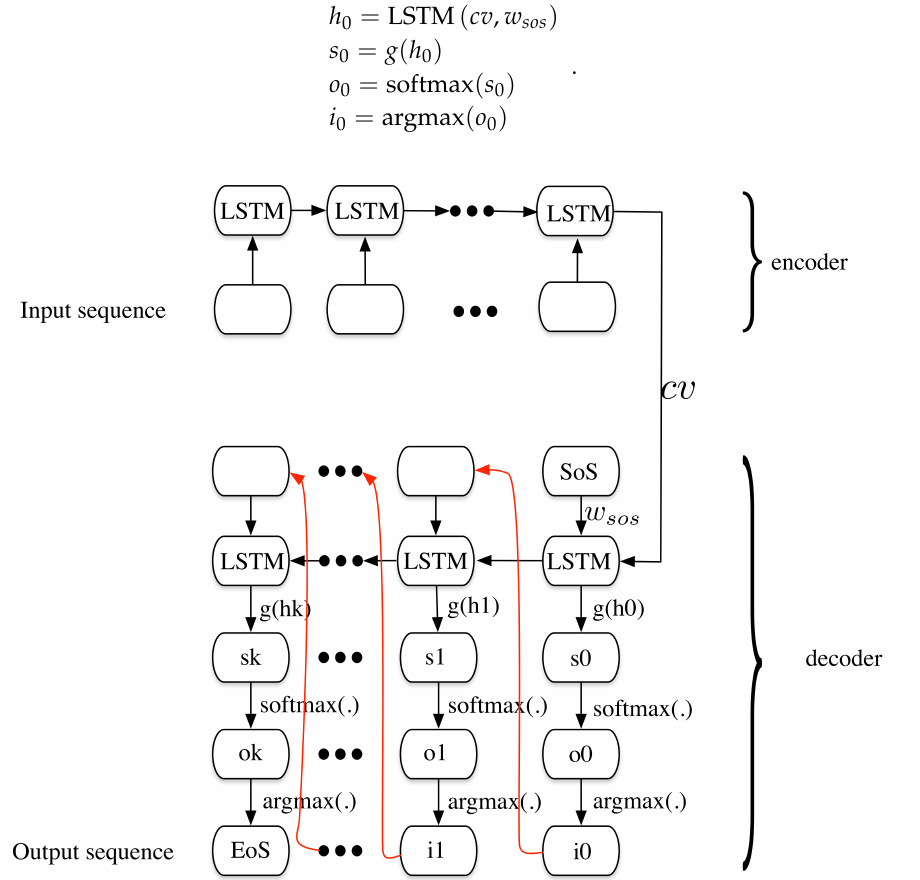
Figure 4. The detailed encoder-decoder structure of the seq2seq